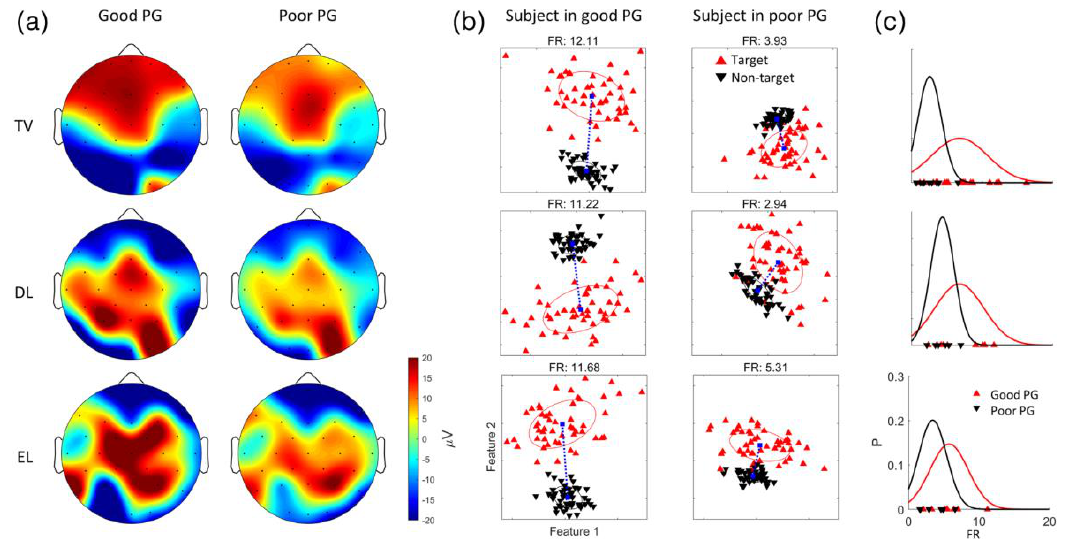
Figure 6. ( a ) ERP amplitude distribution of the good performance group (Good PG) and the poor performance group (Poor PG). ( b ) Examples of the feature spaces of the best performing subject (in Good PG, subject 2) and the worst performing subject (in Poor PG, subject 28). Red triangles denote feature vectors in the target class, and dark inverted triangles denote those in the non-target class. Blue squares indicate the mean of each class. Dotted blue lines denote the distance between the means of two classes. Solid red or dark ellipses represent a contour of the multivariate normal distribution of each class. ( c ) The normal distribution of Fisher’s ratios per group. P indicates probability in the distribution. Red and dark triangles denote subjects in Good PG and Poor PG, respectively.